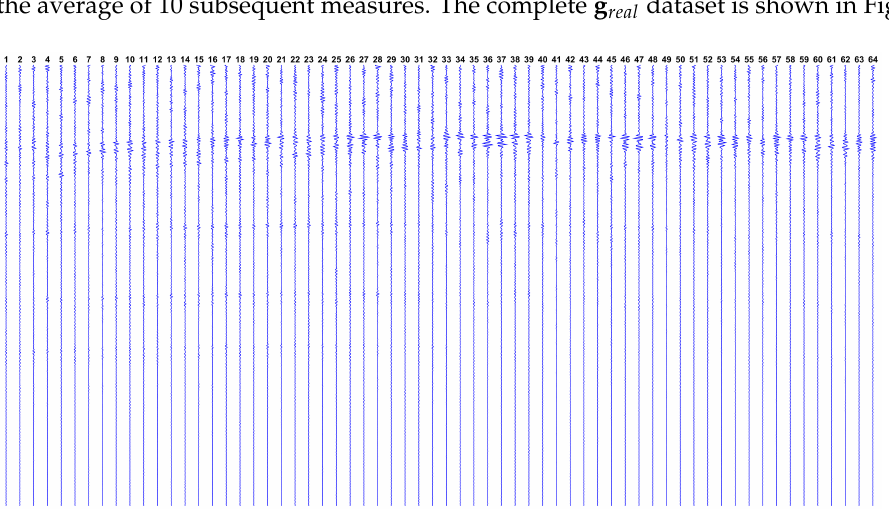
Figure 10. The real dataset g real collected by the Verasonics ultrasound research platform from Fluke phantom device. Each vertical line represents the dataset from a single transducer, over time t i (increasing from top to